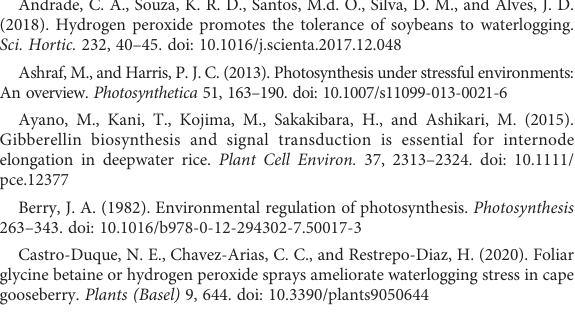
SUPPLEMENTARY FIGURE 1 The details of meteorological data during maize waterlogging periods. SUPPLEMENTARY TABLE 1 Jip-test speci fi es the parameter